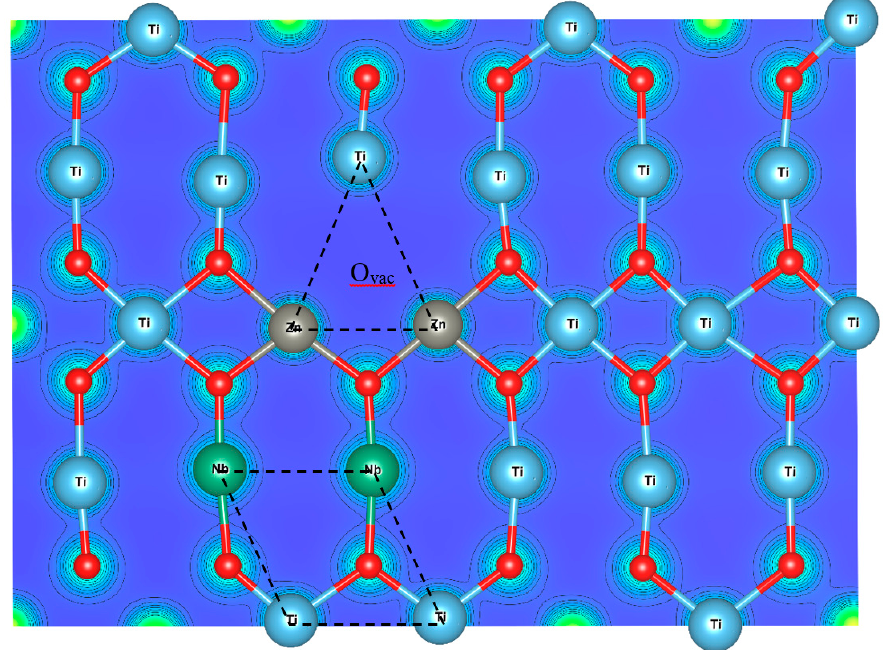
Figure 9. Energy-preferable structure of the 2ZnV o triangular defect and 2Nb diamond defect.